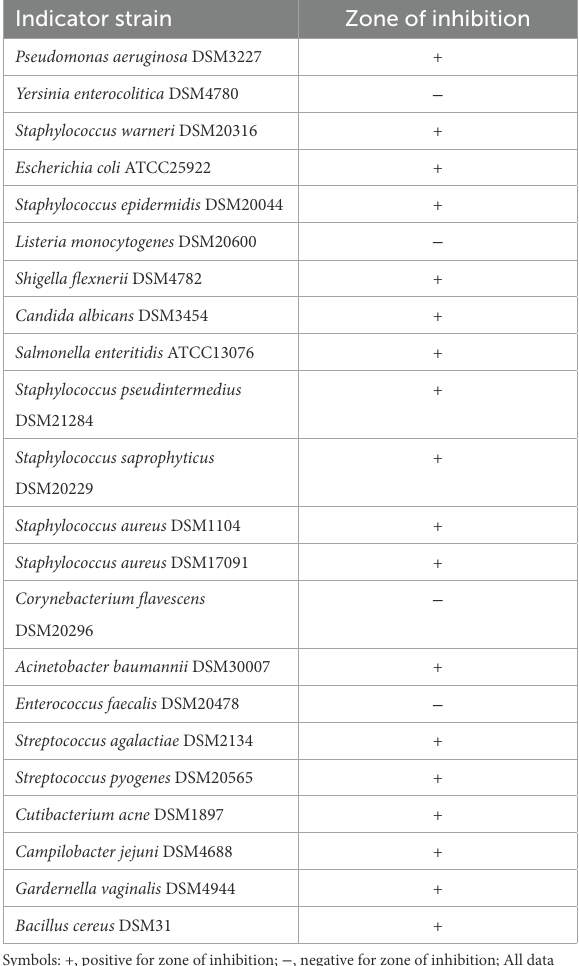
Symbols: +, positive for zone of inhibition; − , negative for zone of inhibition; All data presented is generated from this